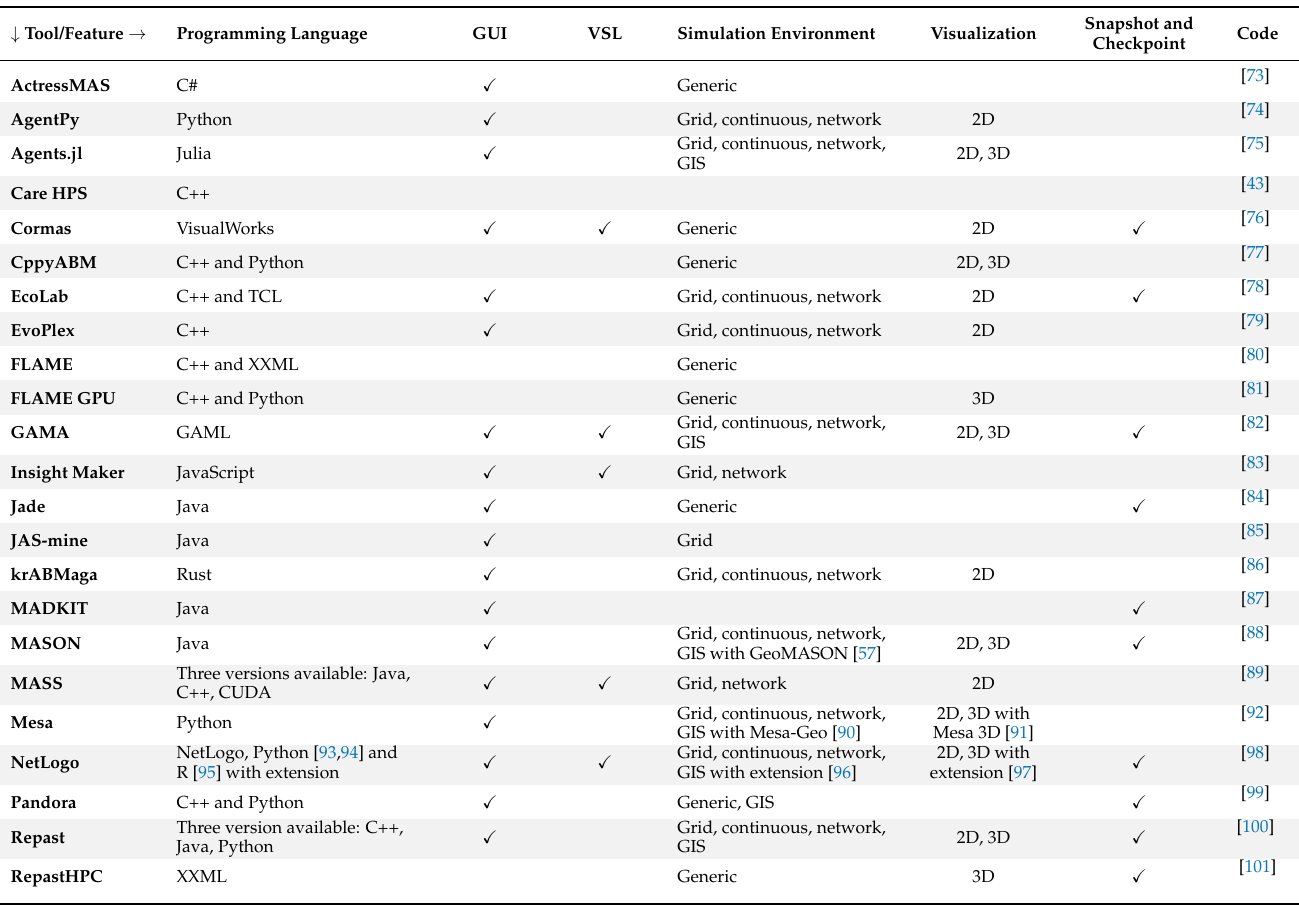
Table 3. Comparison of ABM tools based on their features.